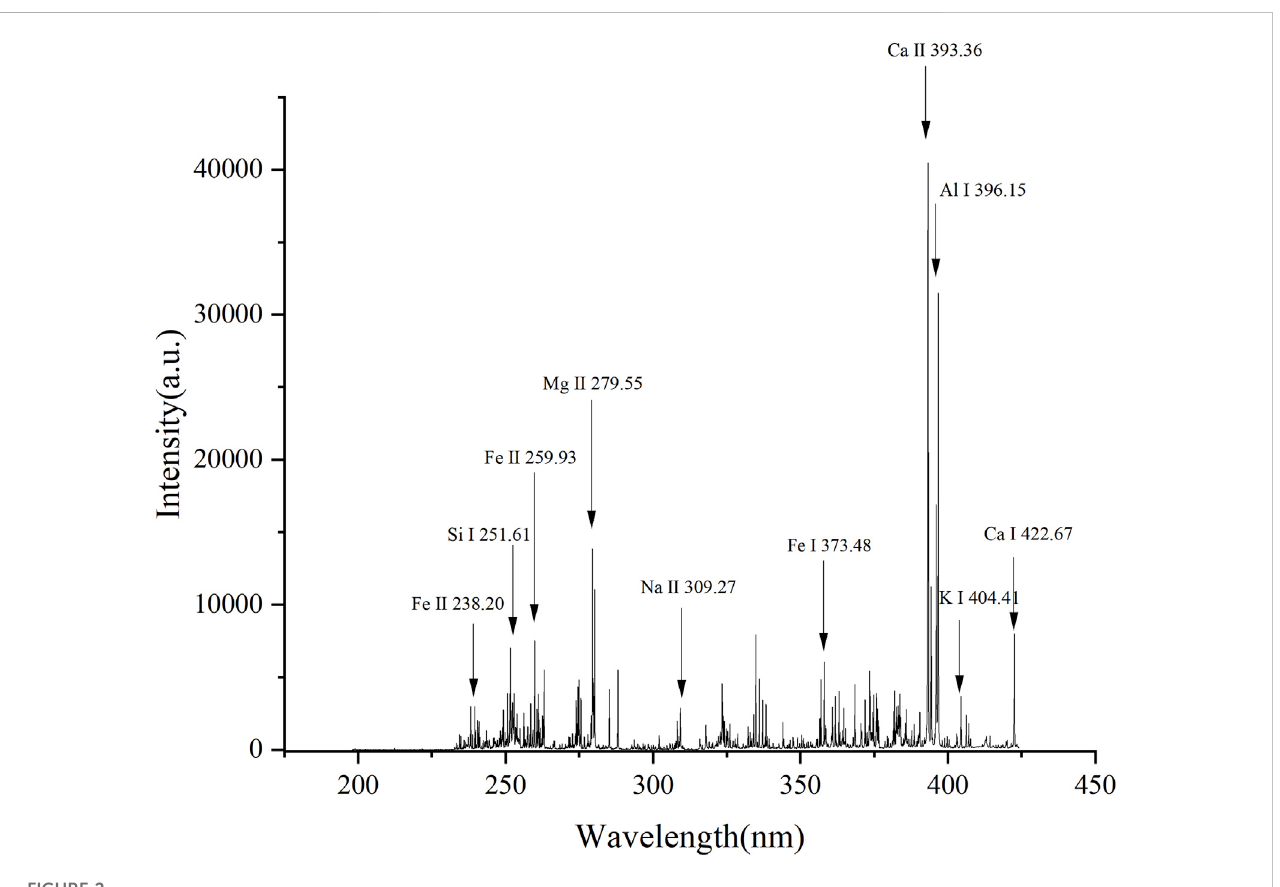
FIGURE 2 LIBS spectrum of soil